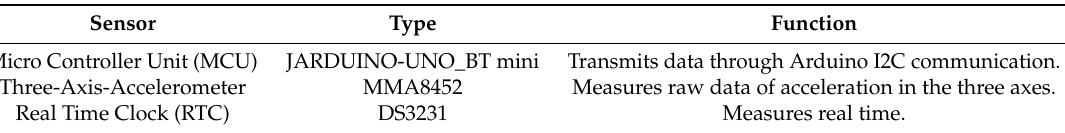
Table 1. Technical Specification of the Sensing Helmet.